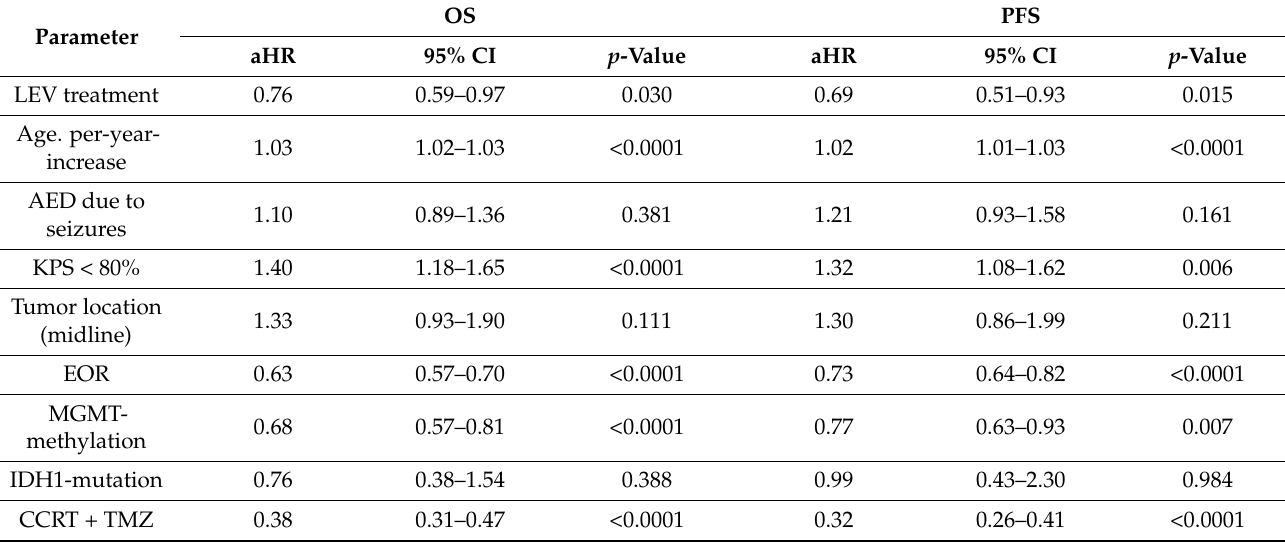
Table 2. Multivariable Cox regression analysis for the association between LEV medication and OS/PFS of GBM in the whole